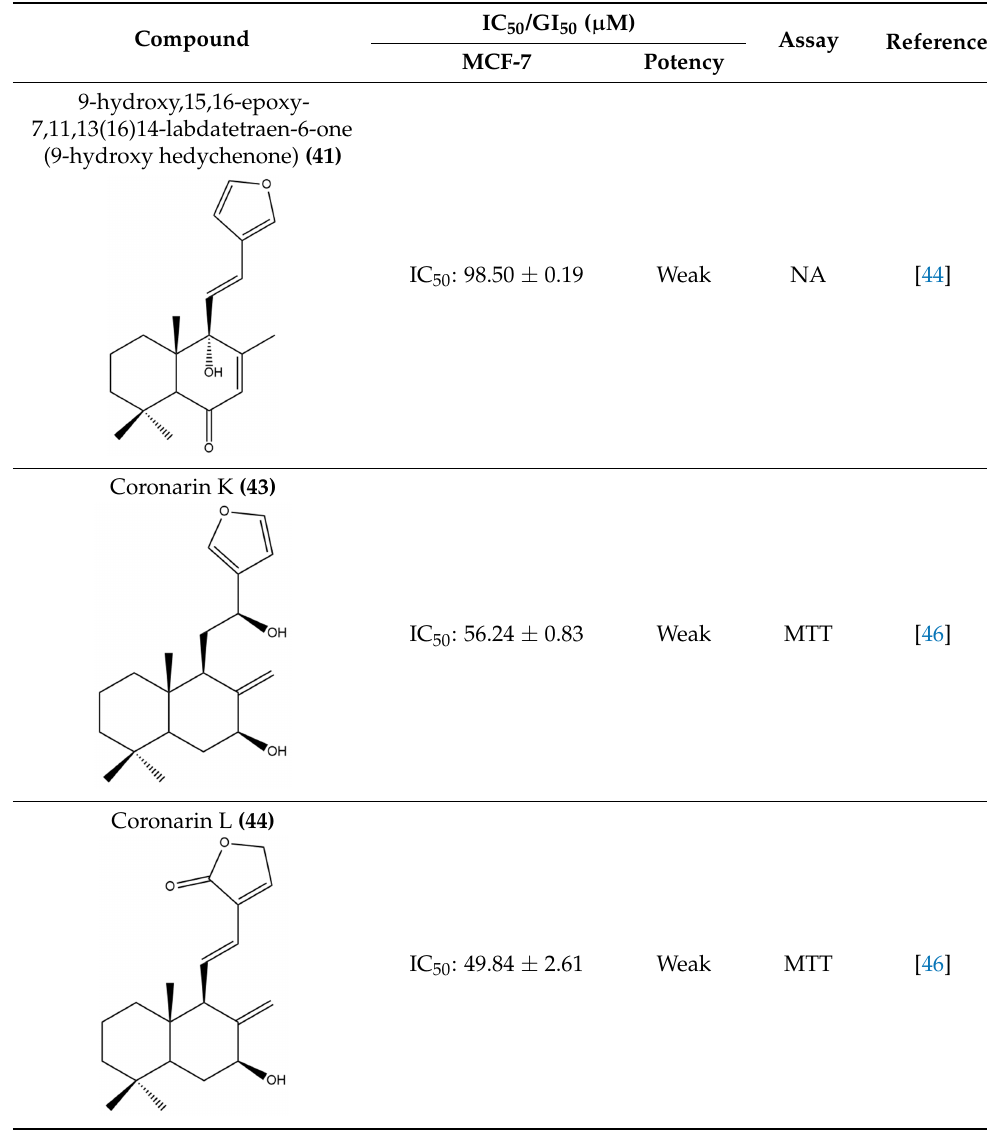
Table 5. Cytotoxic activities of labdane-type diterpenes from the Zingiberaceae against T-47D breast cancer cell line.